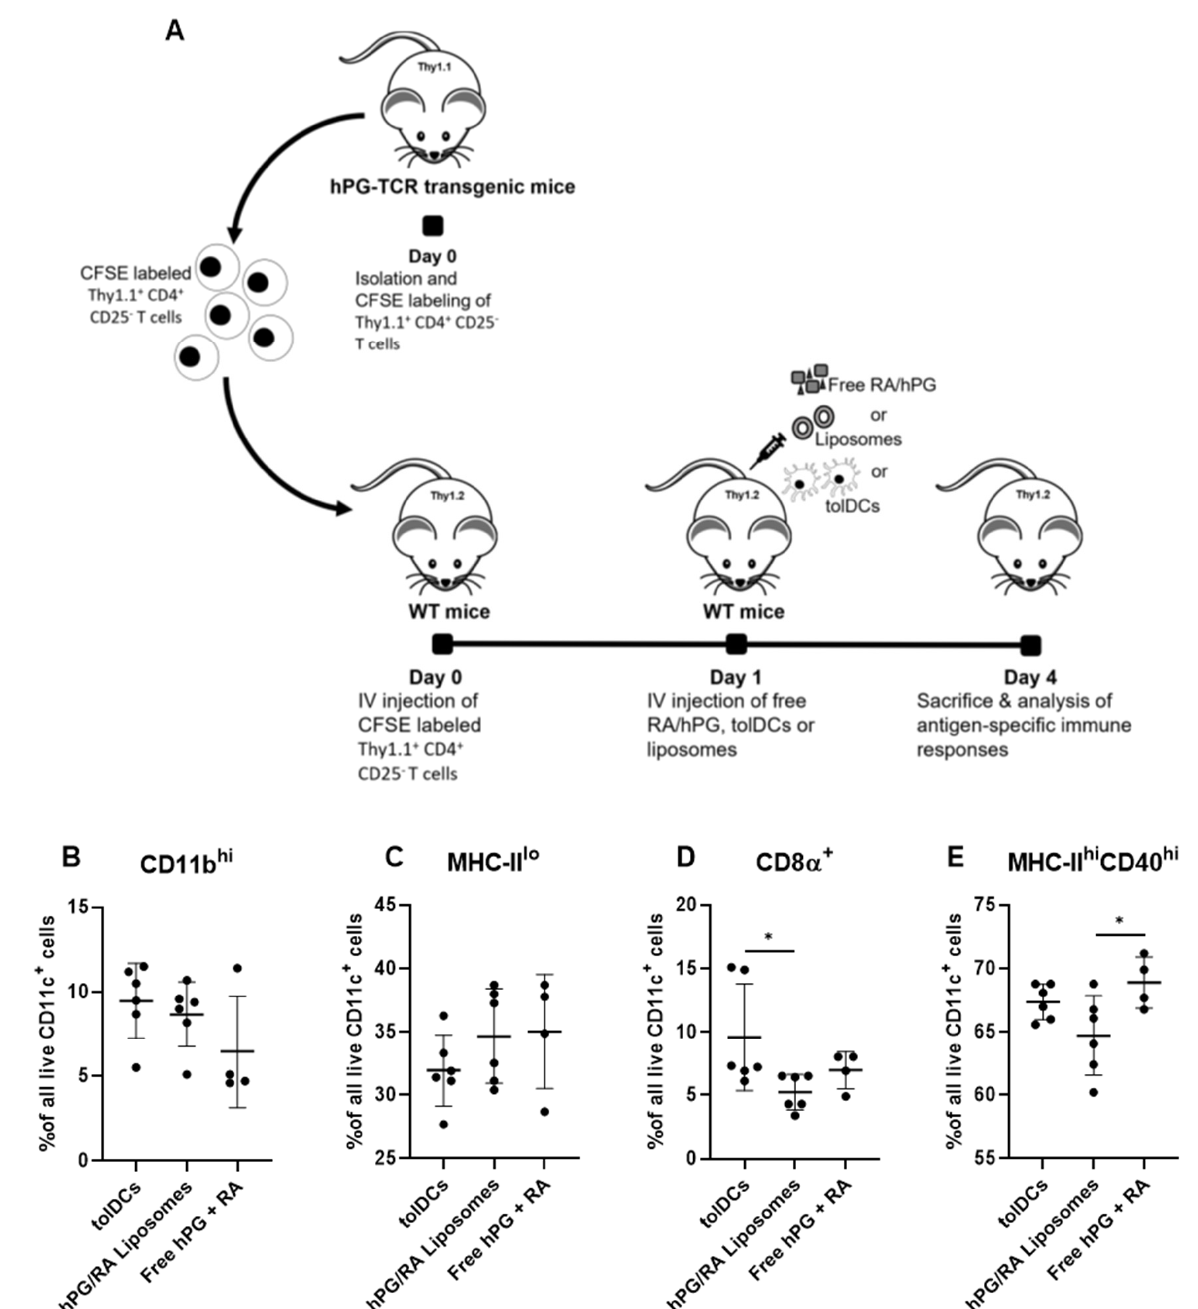
Figure 6. Effect of RA and hPG delivery on splenic DCs in vivo. ( A ) After adoptive transfer of Thy1.1 + CD4 + CD25 − T cells, mice received intravenous injections of either tolDCs pulsed with hPG + RA (tolDCs), liposomes encapsulating hPG + RA (hPG/RA liposomes), or free hPG + RA (free hPG + RA). Three days after injection, splenic DC populations (in live CD11c + cells) were assessed by flow cytometry. The % of ( B ) CD11b hi DCs, ( C ) MHC-II lo DCs, ( D ) CD8 α + DCs and ( E ) MHC-II hi CD40 hi DCs were determined. n = 6 for tolDCs and hPG/RA Liposomes, n = 4 for free hPG + RA control. Means ± SD, * p < 0.05 determined by one-way ANOVA and Tukey’s multiple comparisons test.